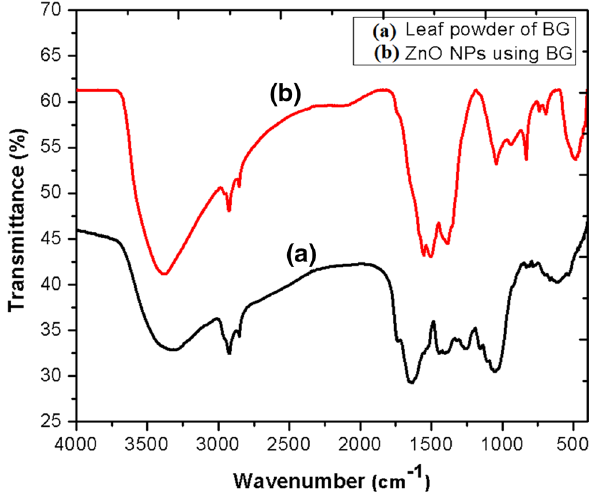
Fig. 6 FTIR of leaf powder of Becium grandiflorum and ZnO NPs